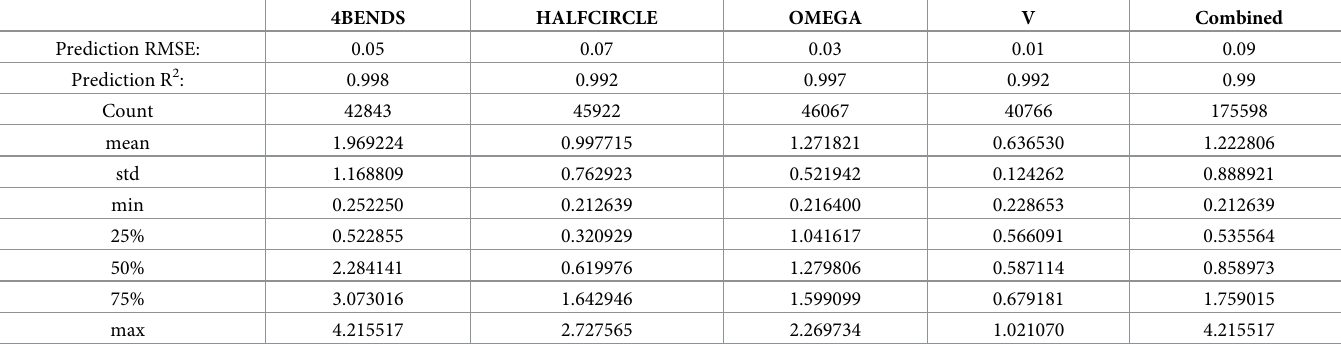
Table 5. Some traditional statistical measures from the learning targets, the measured force time series. This was analysed to verify and justify the robustness of the prediction outcomes from a XGBOOST regression model.